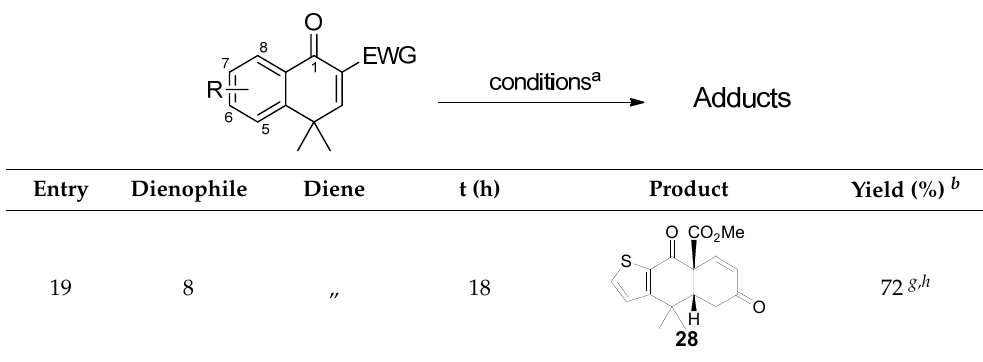
Table 2. Cont. Table 2. Scope of dienophiles and dienes applied for Diels–Alder cycloaddition a